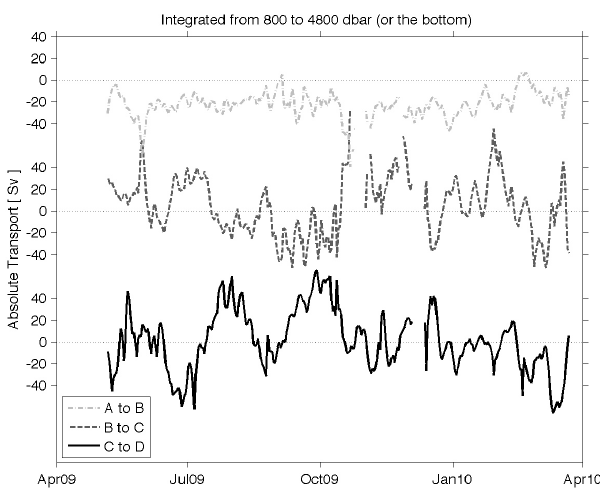
Fig. 7. Absolute transport integrated within the DWBC layer (800– Figure 7: Absolute transport integrated within the DWBC layer (800-4800 dbar) and 4800dbar) and between the indicated pairs of PIES/CPIES (see between the indicated pairs of PIES/CPIES (see Figure 1 for locations). Standard Fig. 1 for locations). Standard deviations of the three records are deviations of the three records are 12 Sv, 27 Sv, and 28 Sv for the A-to-B, B-to-C and C- 12, 27, and 28Sv for the A-to-B, B-to-C and C-to-D spans, respec- to-D spans, respectively